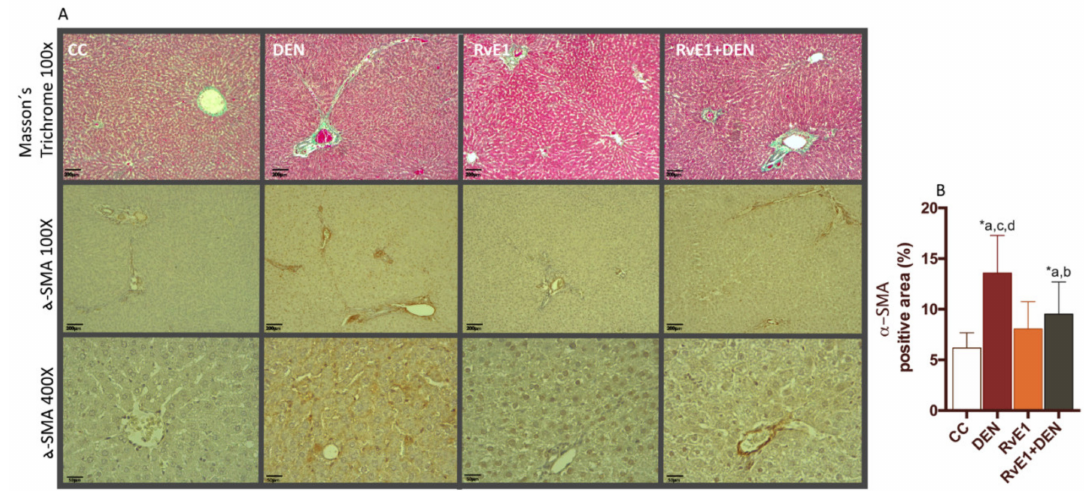
Figure 2. E ff ect of RvE1 on matrix deposit. ( A ) Representative histopathological microphotography of liver. Upper panel: Representative Masson´s trichrome. Middle panel: Representative images of α -SMA staining at 100 × . Lowe panel: Representative images of α -SMA staining at 400 × . ( B ) Quantification of α -SMA positive areas. At least 20 fields for every sample were analyzed at 400 × magnification. n = 6 animals per experimental group. Asterisk indicates p < 0.05, and the letters identify the experiments that are compared and present this statistical di ff erence.